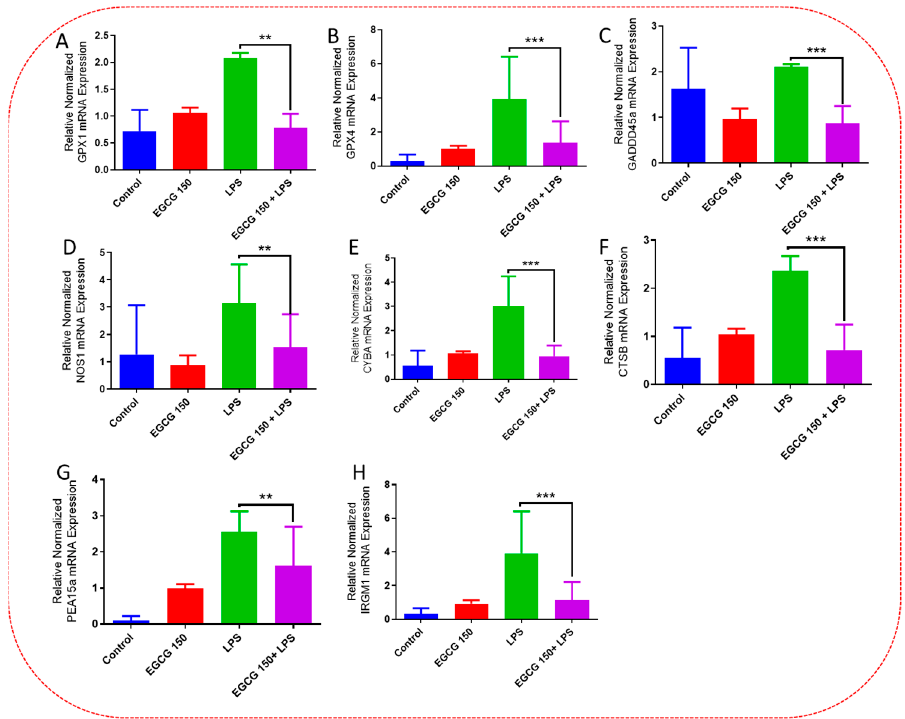
Figure 13. EGCG downregulated oxidative stress–producing NO genes. PCR array analysis displayed that EGCG 150 µM coupled with LPS (1 µg/mL) lowered mRNA expression of the genes GPX1 ( A ), GPX4 ( B ), GADDD45A ( C ), NOS1 ( D ), CYBA ( E ), CTSB ( F ), PEA15A ( G ), and IRGM1 ( H ) compared to LPS. Values represent the mean ± SD ** p ≤ 0.01, and *** p ≤ 0.001 vs. LPS.